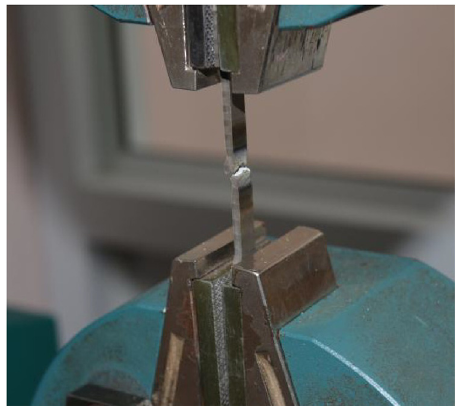
Figure 8: Schematic diagram showing the fractured tensile spe - cimen in the gripper.